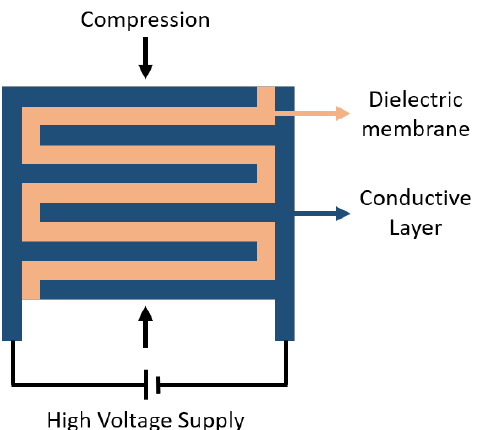
Figure 2. Cross-sectional view of the stacked DEA structure. Interdigitated conductive layers are isolated from each other by the serpentine-shaped dielectric material between. On each side, alternating conductive layers are interconnected and attached to a power source. The actuator is compressed in the perpendicular direction (indicated by the arrows) when a voltage is applied and expands in the lateral direction.